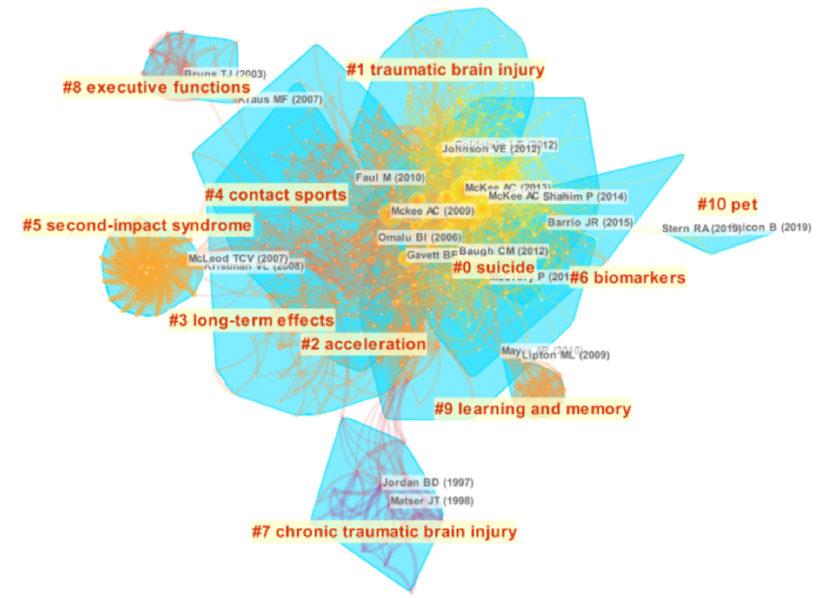
Figure 7. The cluster view of the knowledge map based on reference co-citation analysis (RCA) of the CTE field from 1999 to 2019.